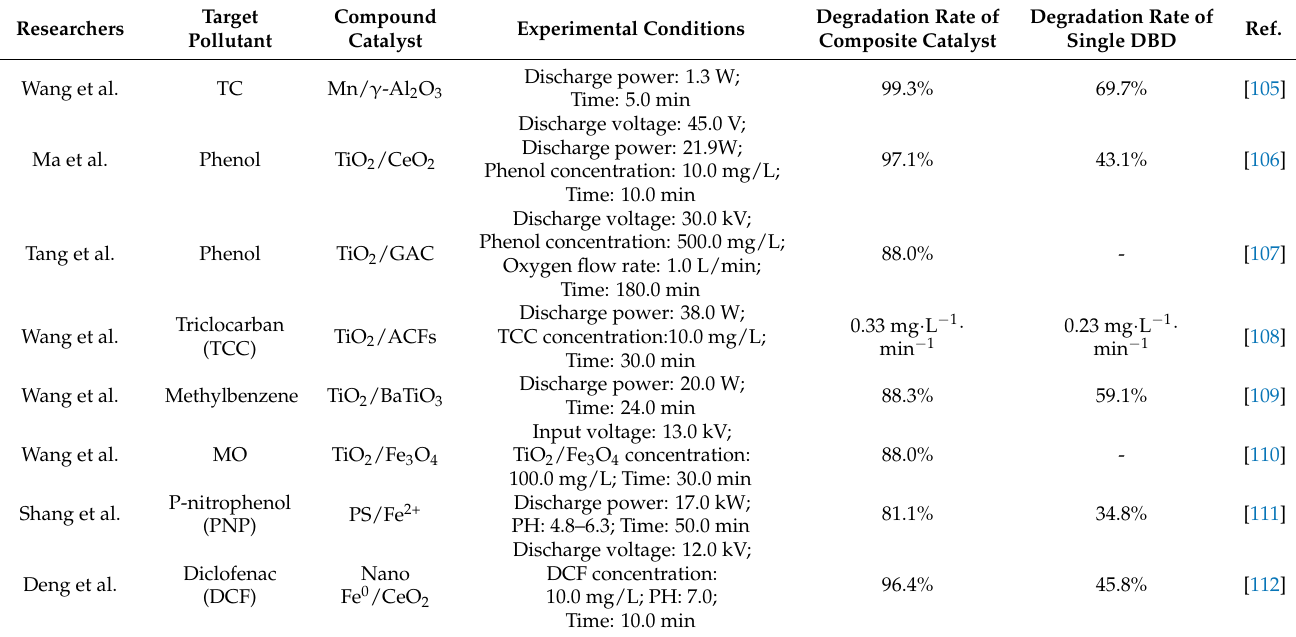
Table 5. Summary of DBD technologies with composite technology for organic wastewater removal.